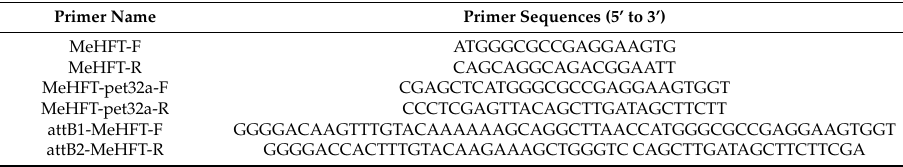
Table 2. The primers used in the present